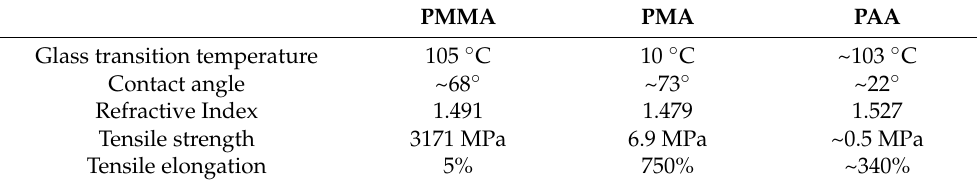
Table 1. Overview about the physico-chemical properties of PMMA, PMA and PAA.